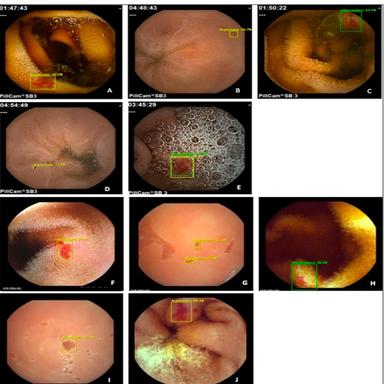
Examples of artificial intelligence-based outputs.